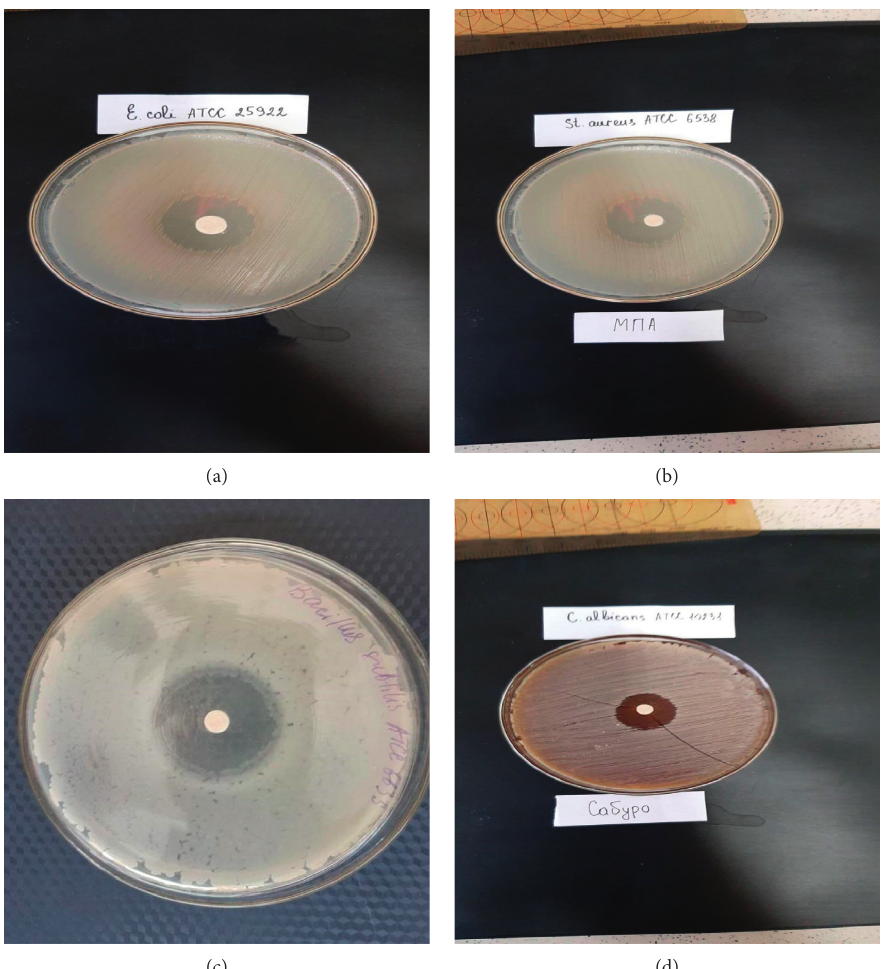
Figure 2: Results of the antimicrobial activity of Portulaca oleracea ’s CO 2 extract obtained by the disco-diffuse method from the Almaty region (Southeast Kazakhstan, 2019): ( a ) E . coli ; (b) S . aureus ; (c) B subtillis ; and (d) C . albicans . Portulaca oleracea ’s CO 2 extract component composition varied according to the raw materials origin, place, and collection timing, which is explained by the difference in soil, climatic, and weather conditions. The chromatographic analysis sum of the main groups of compounds by classes is presented in Figure